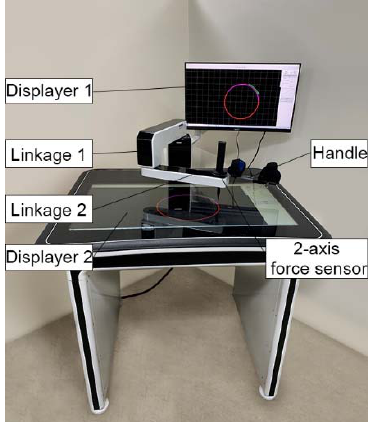
Figure 1. The structure diagram of the upper limb rehabilitation Robot.